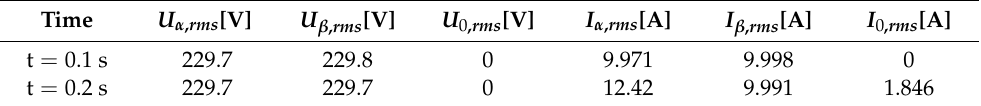
Table 38. Simulation results before and after the change (at steady states).